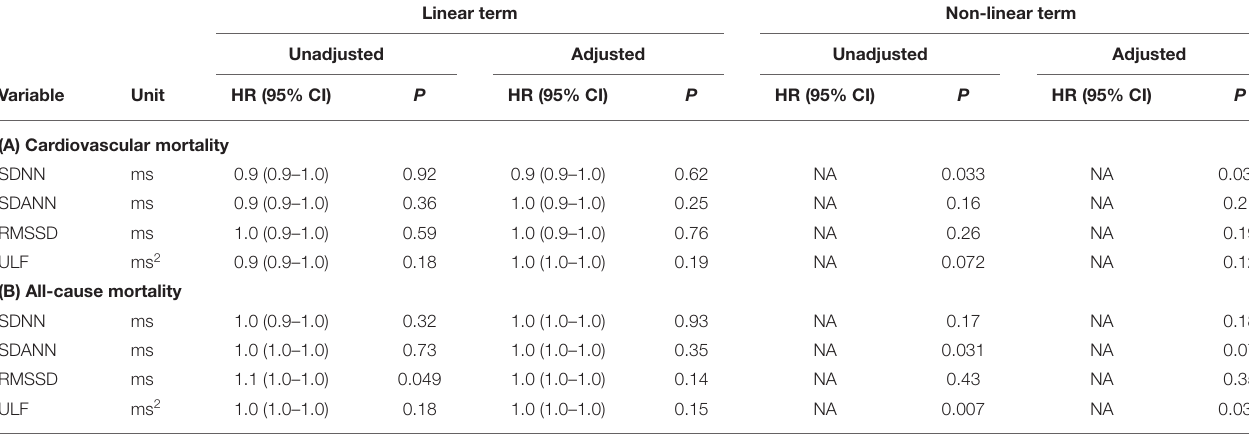
Adjusted model includes the predictor, the Charlson Comorbidity Index, and Cardiovascular Mortality Risk Score. CI, confidence interval; HR, hazard ratio; NA, not applicable; SDNN, standard deviation of all NN intervals; SDANN, standard deviation of the averages of NN intervals in all 5-min segments of 24h recording; RMSSD, square root of the mean square